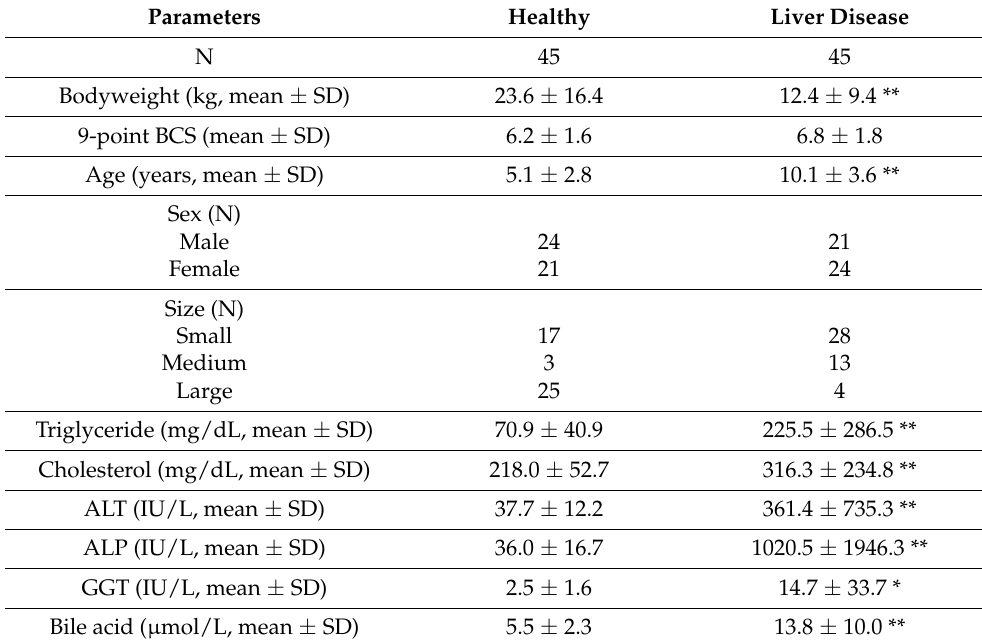
Table 1. General characteristics of healthy dogs and dogs with chronic hepatitis.